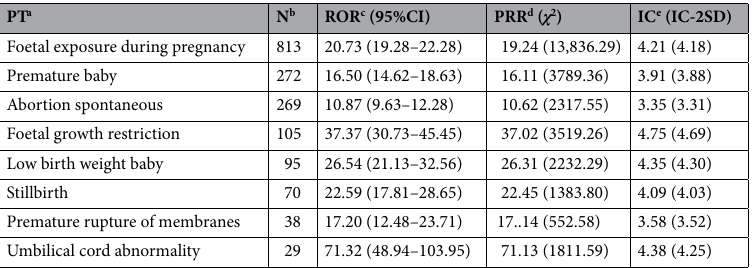
Table 5. Signal strength of pregnancy, puerperium and perinatal conditions for darunavir and its boosted agents. a PT: Preferred terms. b Number of patients with adverse events. c ROR reporting odds ratio. The lower limits of the 95% CI of the ROR greater than 1 indicated statistically significant RORs. d PRR proportional reporting ratio. PRR and χ 2 greater than 2 and 4 respectively indicated statistically significant PRRs. e Information component. The signal was statistically significant when IC-2SD > 0.